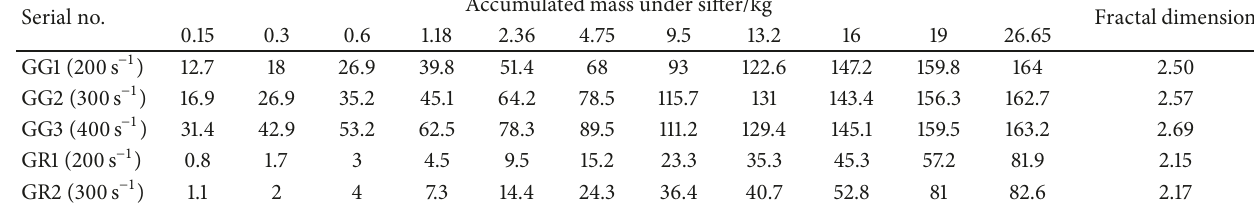
Table 2: Filtered results of mass distribution of fragment size.